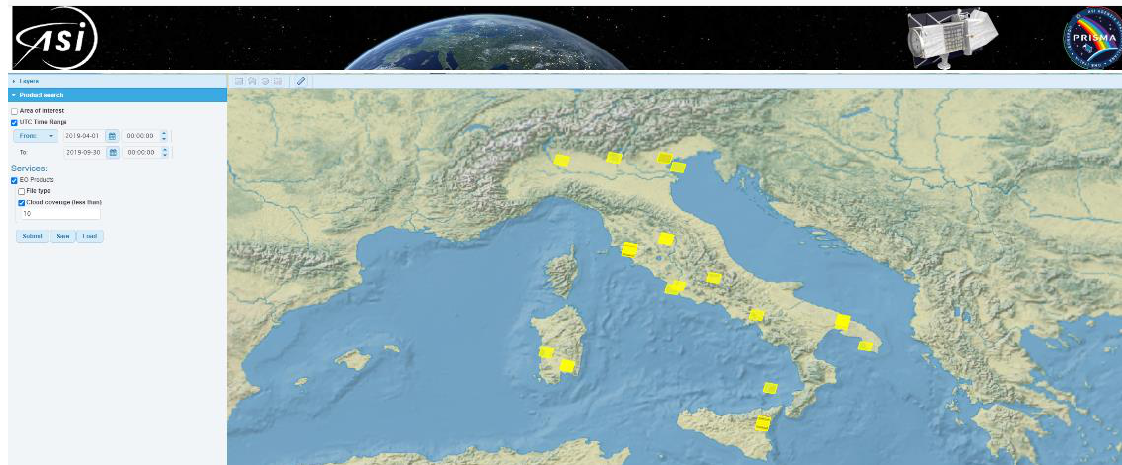
Figure 1. Spatial distribution of all the 23 PRISMA images from the portal prisma.asi.it available in Italy, all of them acquired in 2019 (with cloud cover lower than 10% and acquisition in the vegetative period).